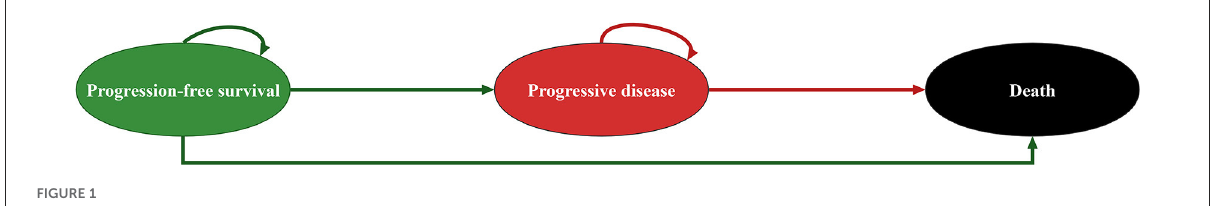
FIGURE1 Diagram of markov